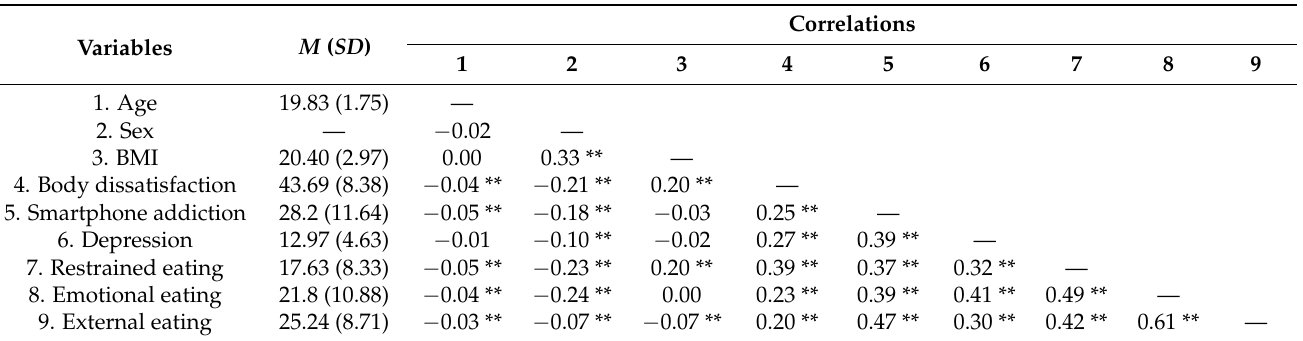
Table 1. Correlations, means and standard deviations of study